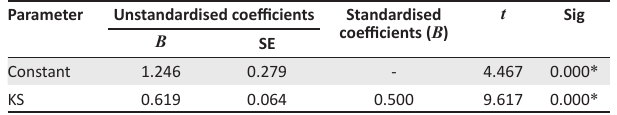
TABLE 10: Parameter estimates for knowledge acquisition on small and medium enterprises’ innovation capabilities model.